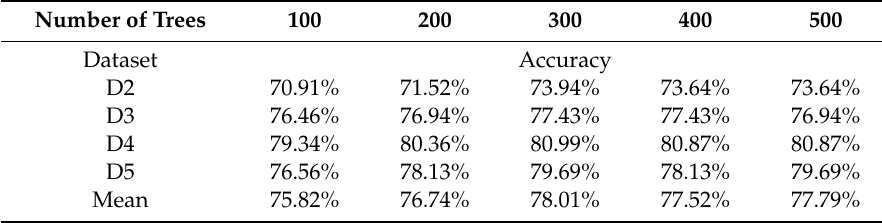
Table 4. Prediction performance of random forest (RF) for the testing